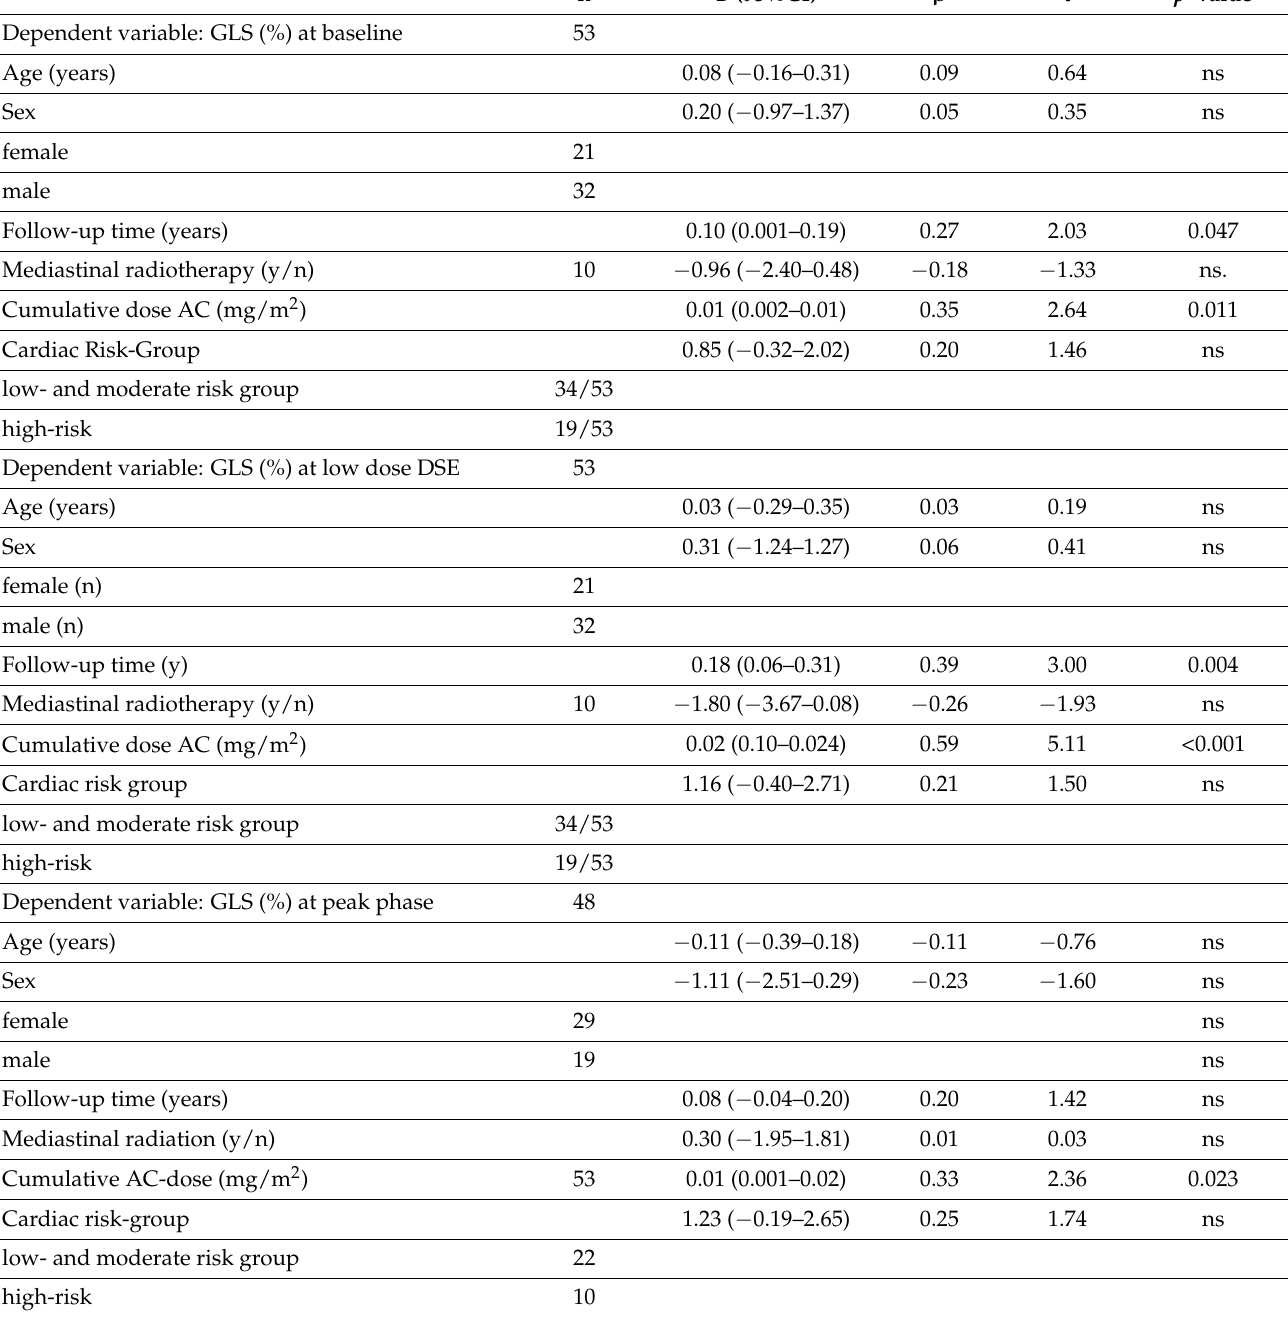
Table 6. Univariate Linear Regression in CCS of GLS during DSE as the dependent variable. n B